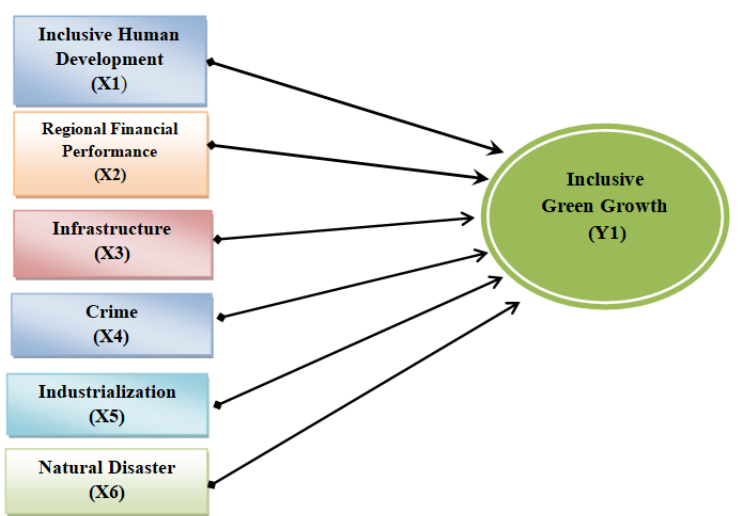
Fig. 3: The conceptual framework of study